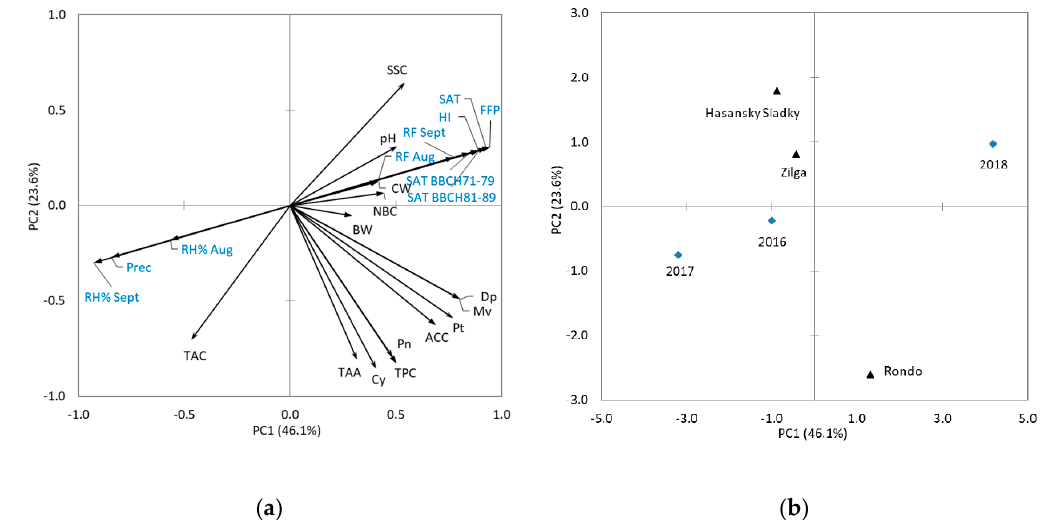
Figure 2. Principal component analysis (PCA) of the structure of biochemical and berry parameters in relation to the cultivar and climatic conditions of experimental years’: ( a ) biochemical and berry parameters in relation to the climatic parameters; ( b ) cultivar in relation to the experimental year. BW—berry